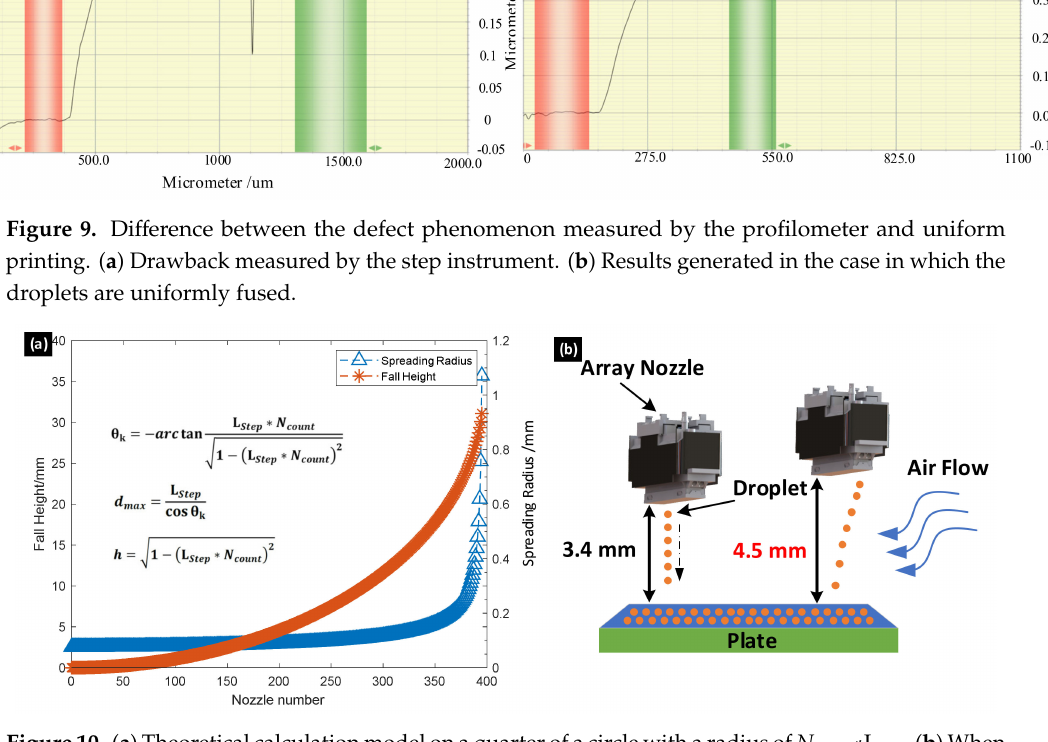
Figure 10. ( a ) Theoretical calculation model on a quarter of a circle with a radius of N count ∗ L Step .( b ) When the ejection distance is greater than 3.4 mm, it will be disturbed by the airflow, which will cause the droplets to fall on the substrate incorrectly. N count , nozzle number; L Step ,